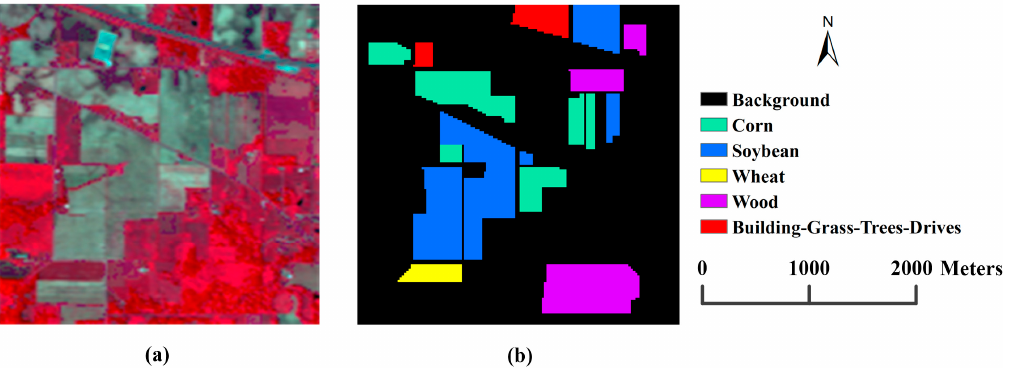
Figure 2. Airborne Visible/Infrared Imaging Spectrometer (AVIRIS) hyperspectral image. ( a ) Three-band color composite image (band 50, 27 and 17); ( b ) Ground truth. Table 1. Ground truth classes for AVIRIS Indian Pines image used in the study and their respective number of samples.